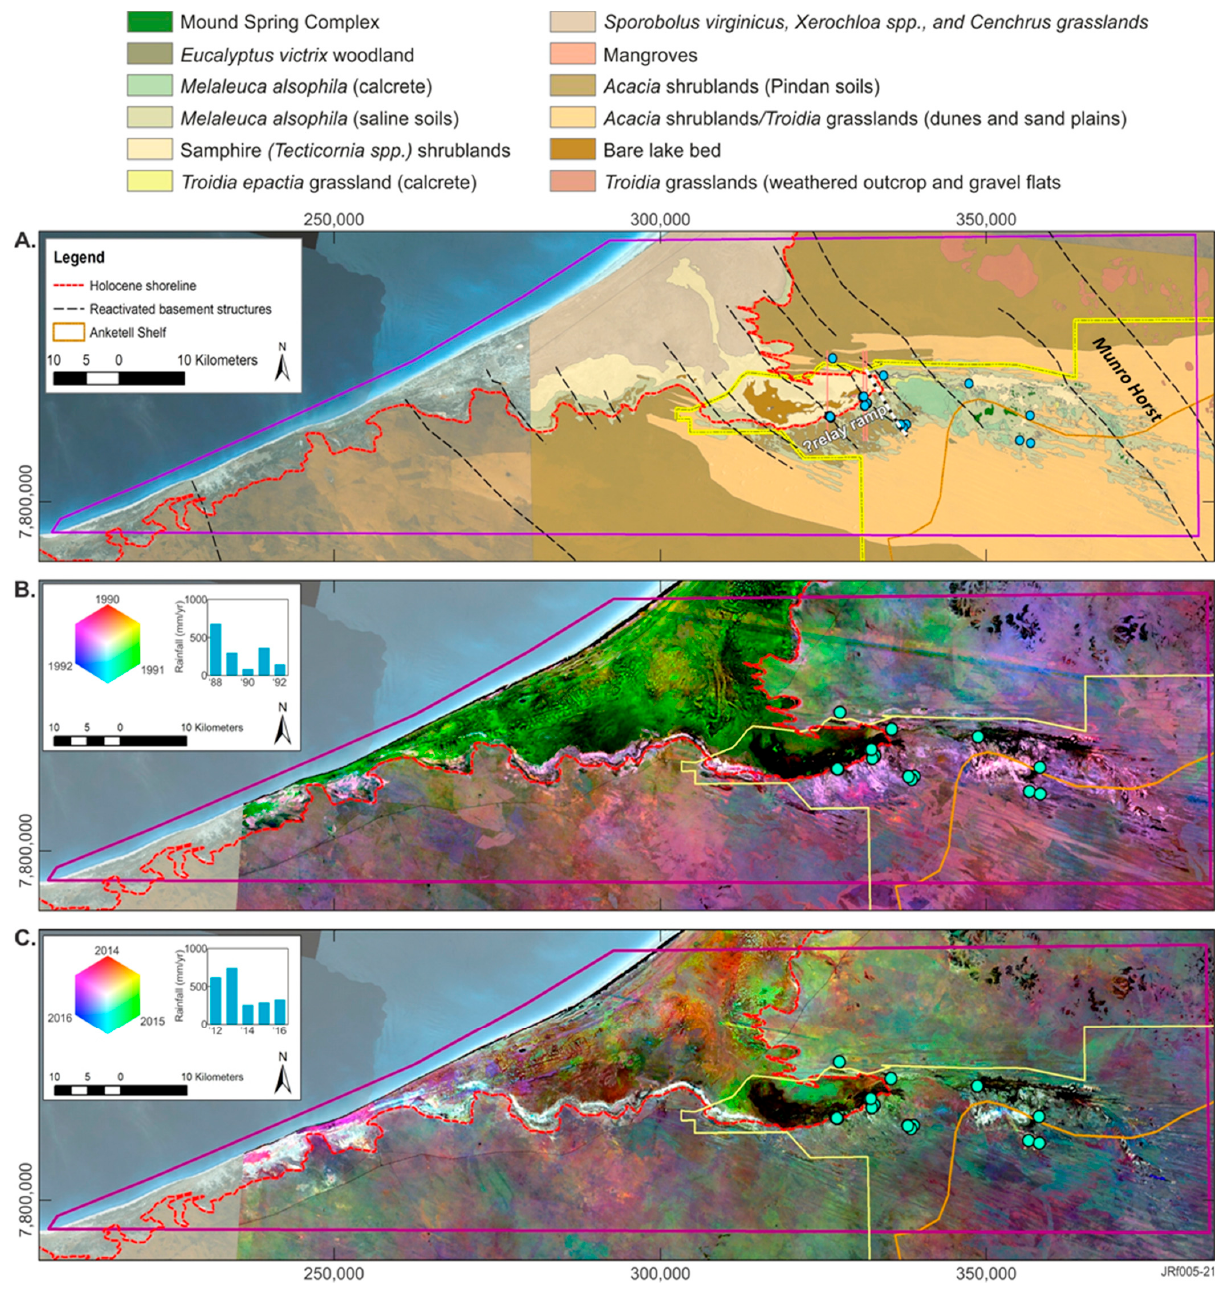
Figure 7. Sub-regional-scale fractional cover models with Park spring sampling locations (blue dots) and the Walyarta Conservation Park boundary (yellow linework): ( A ) Vegetation map [47] with broad-scale physiographic constraints (e.g., Munro Horst and connecting fault (white dashed line) and approximate location of relay ramp (see Figure 6); ( B ) Fractional cover model displayed as composite image of average annual vegetation for years 1990, 1991 and 1992. Bar graph displays annual rainfall for 1988 to 1992; ( C ) Fractional cover model displayed as composite image of average annual vegetation for years 2014, 2015 and 2016. Bar graph displays annual rainfall for 2012 to 2016.